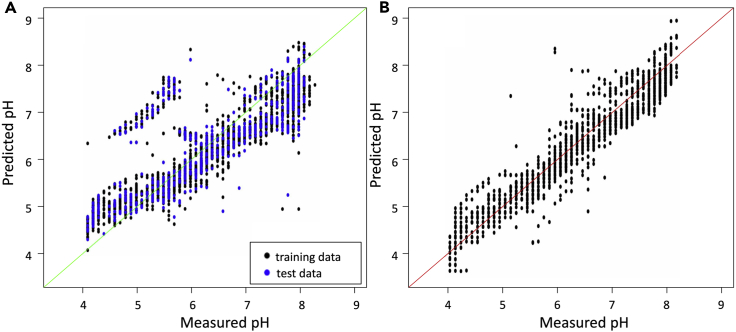
Predicted pH Values Plotted against the Measured pH for Wells Containing Ammonium Salts(A) The results from the initial ammonium salt model built including all ammonium salts, showing the separate cluster corresponding to hydrogen and dihydrogen salts.(B) The results from the model built after removing hydrogen and dihydrogen salts. Five wells with measured pH 4 and predicted pH values between pH 2 and 3.5 are not plotted.